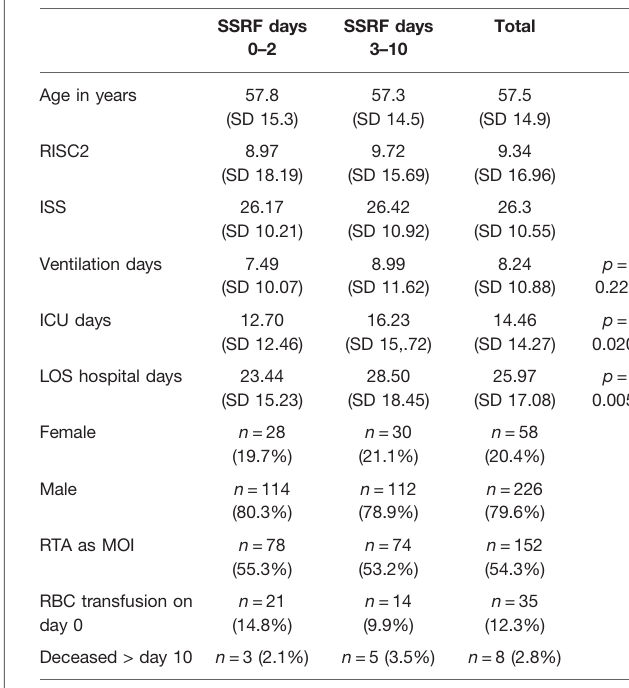
TABLE 2 | Matched-pairs groups: surgical stabilization on days 0 – 2 vs. 3 –